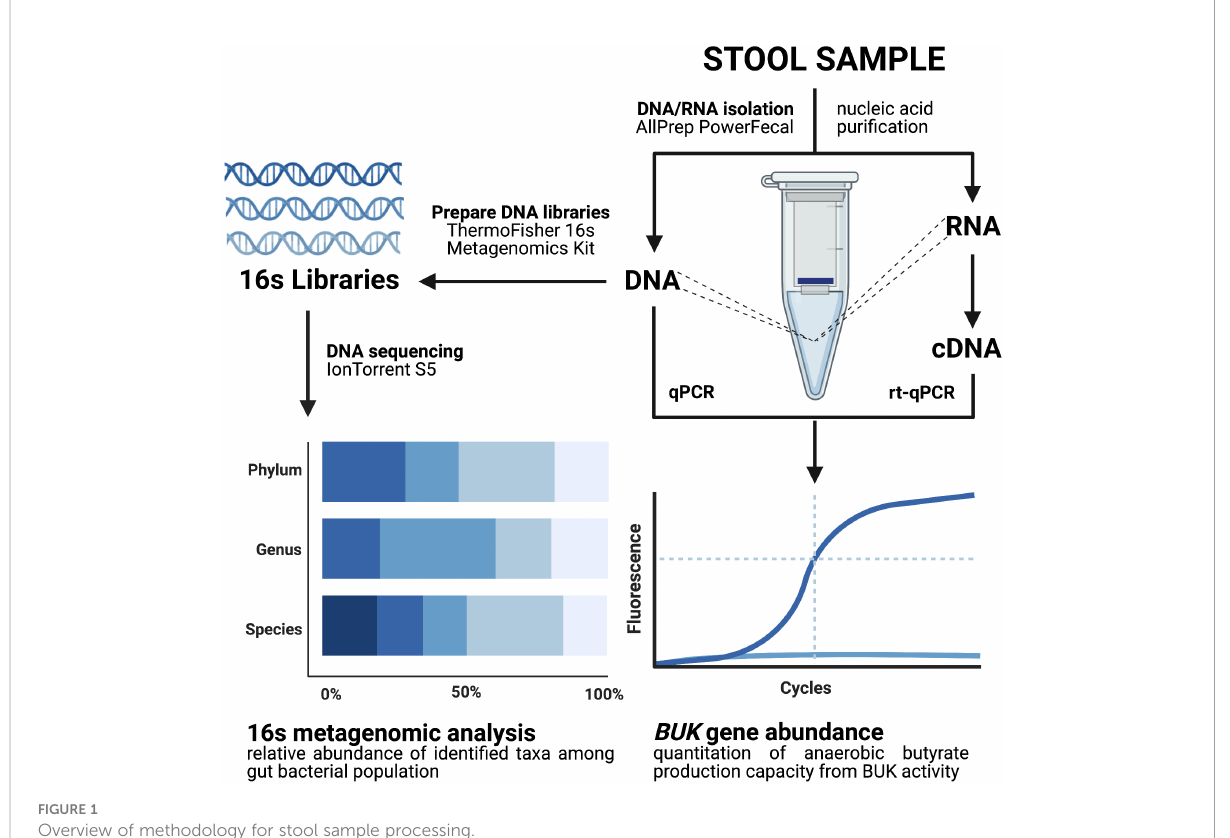
FIGURE 1 Overview of methodology for stool sample